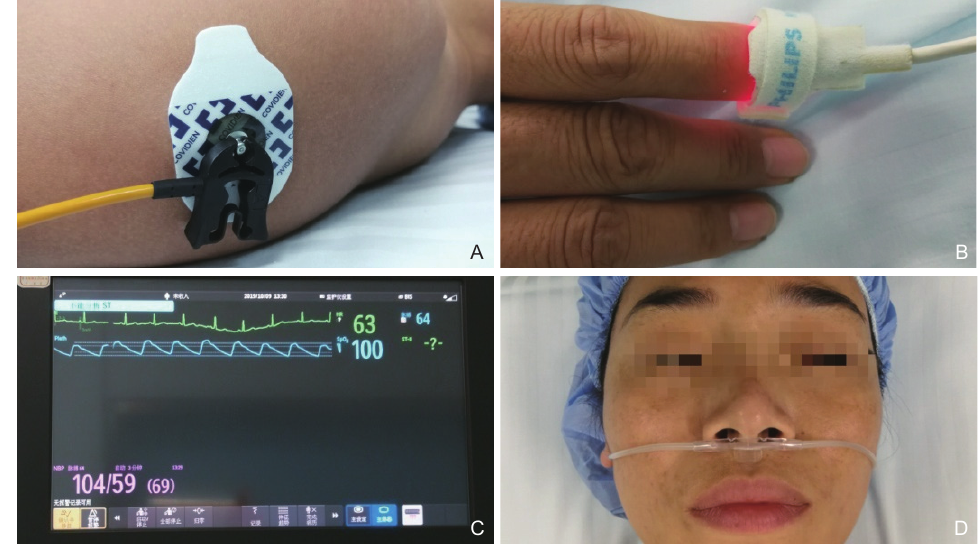
Figure 3 Intra-operative monitoring and oxygen supply. (A) Electrocardiogram monitoring electrode; (B) The infrared blood oxygen monitoring sensor, which can work on fingertips as well as toes; (C) Real-time monitoring displays of electrocardiogram, blood oxygen saturation, and blood pressure; (D) Nasal oxygen tube continuously supplying